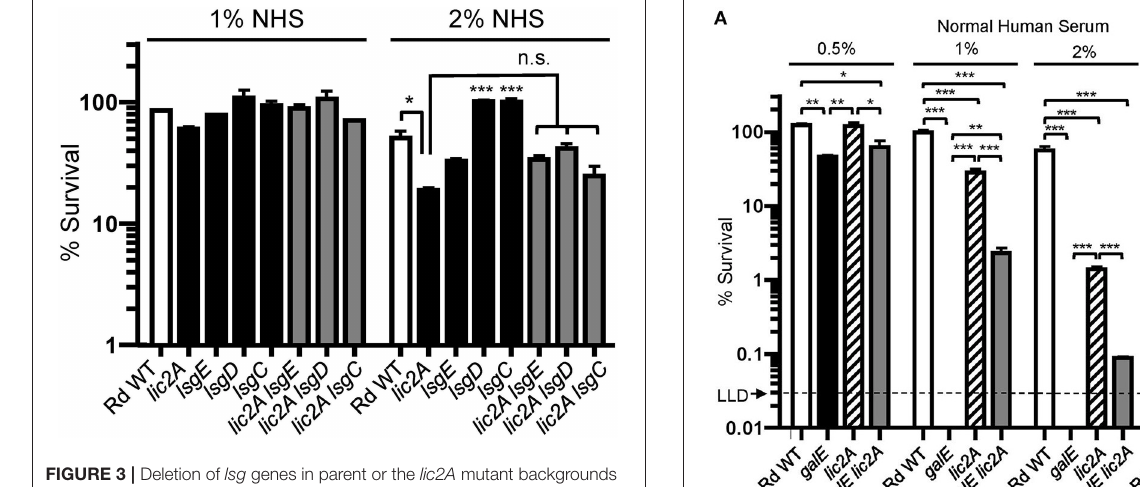
FIGURE 3 | Deletion of lsg genes in parent or the lic2A mutant backgrounds does not significantly increase serum sensitivity. Viability of Rd wild-type (WT) and isogenic deletion mutants lic2A , lsgE , lsgD , lsgC, and double deletion mutants lic2A lsgE , lic2A lsgD , and lic2A lsgC grown in sBHI medium was assayed following incubation with 1 and 2% normal human serum (NHS) at 37 ◦ C for 30min. Percent survival is the ratio of CFU recovered from serum treated samples at 30min to CFU recovered from heat inactivated serum (NHS 1 I ) treated samples. The mean of two independent samples is shown. The lsgD and lsgC mutants each exhibited statistically significant increase in survival compared to all other samples at 2% NHS. Statistical significance is evaluated by one-way ANOVA with Bonferroni’s multiple comparison test (*** p < 0.001; * p < 0.05).